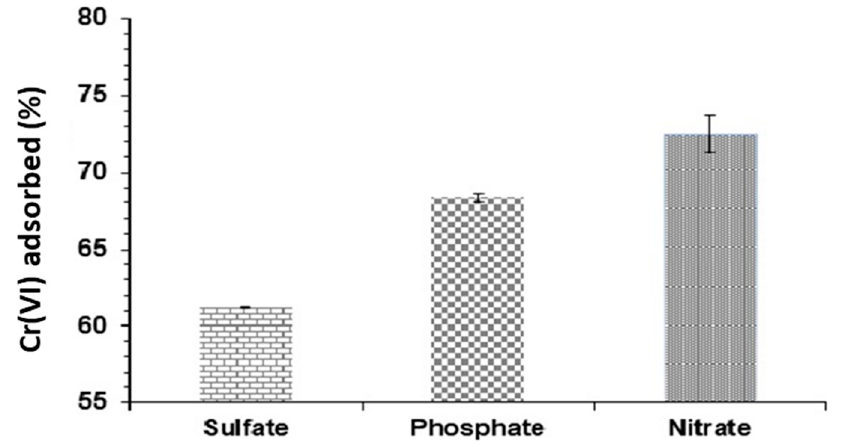
Figure 2. The Cr(VI) adsorption (%) in the occurrence of competing ions.